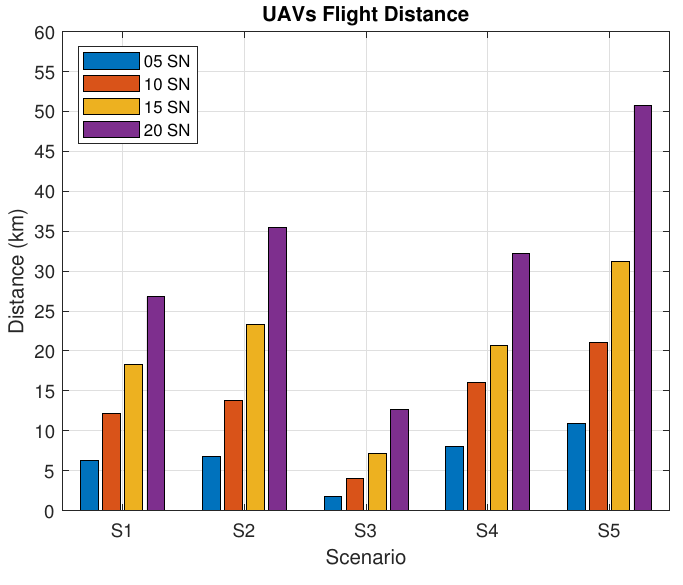
Figure 15. Flight path for each scenario.